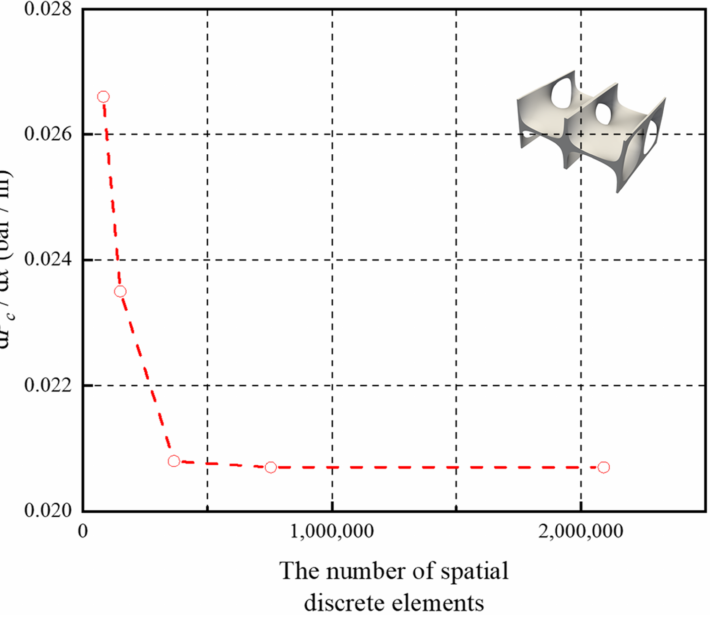
Figure 3. The mesh independence analysis of the computational domain composed of CLP spacer at u = 0.093